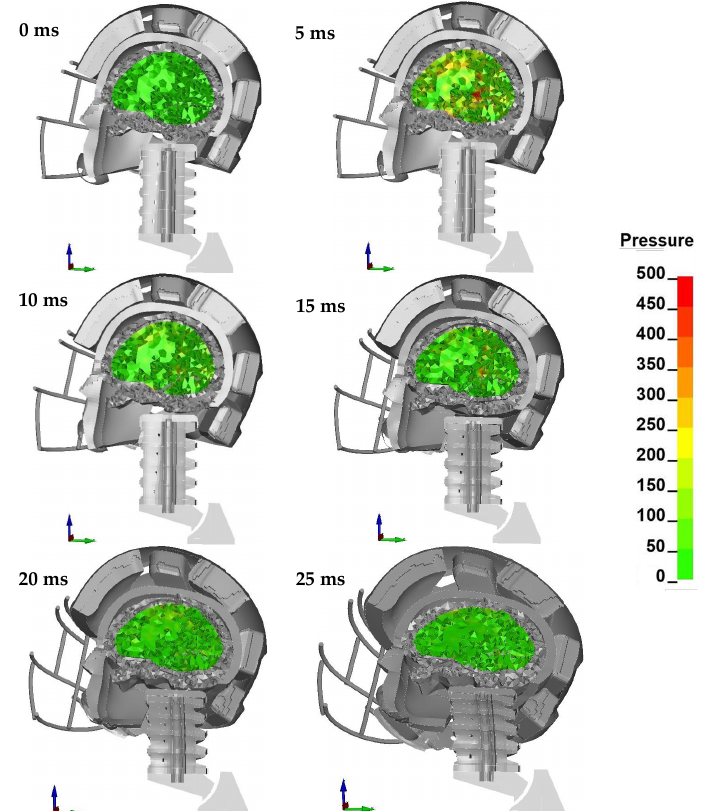
Figure A9. Head kinematics during the numerical test, configuration C, with the cross-section in the median plane and showing the hydrostatic pressure (kPa) in the cerebrum.